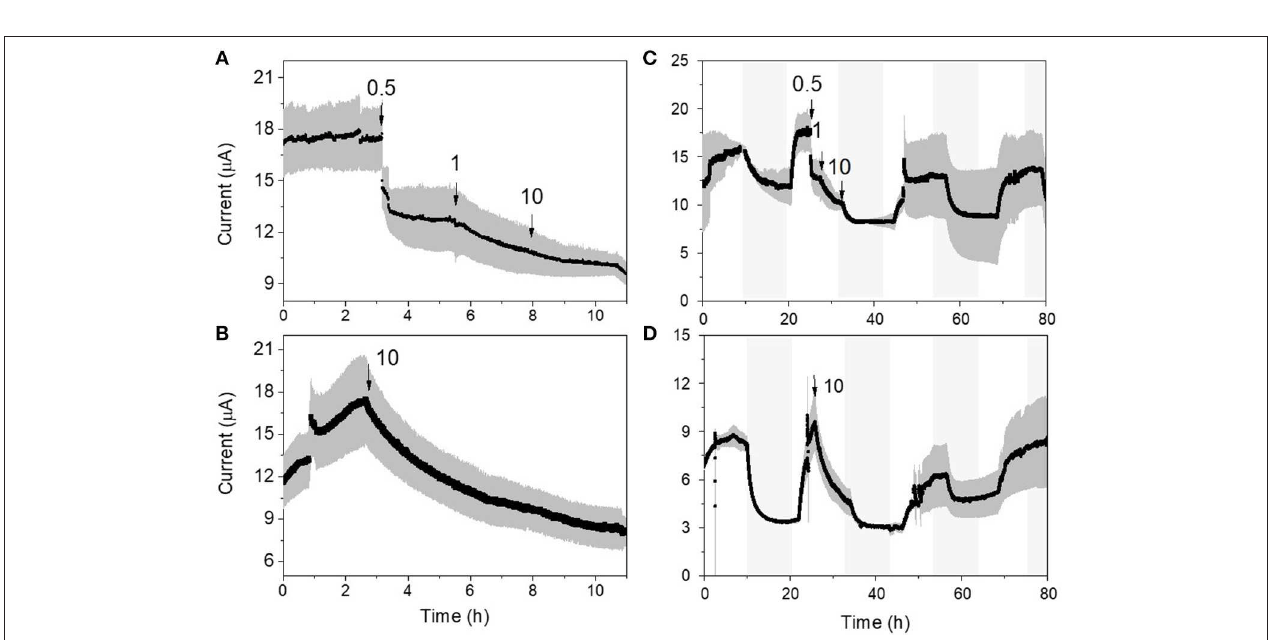
FIGURE 7 | Response of the p-MFC ITO sensor to atrazine. (A) and (C) response to subsequent injections of atrazine for concentrations ranging between 0.5 and 10mg L − 1 . (B) and (D) response to a single atrazine injection of 10mg L − 1 . (A,B) show the short-term response (i.e., up to 10h), while (C,D) the response up to 80h. Shadowed areas indicate the operation during the dark